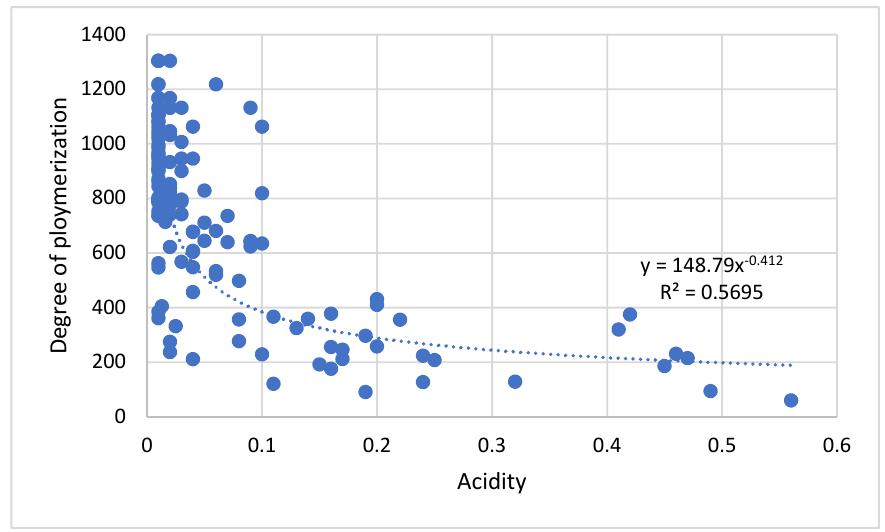
Figure 4. Relationship between DP and ACI as a power fitting.